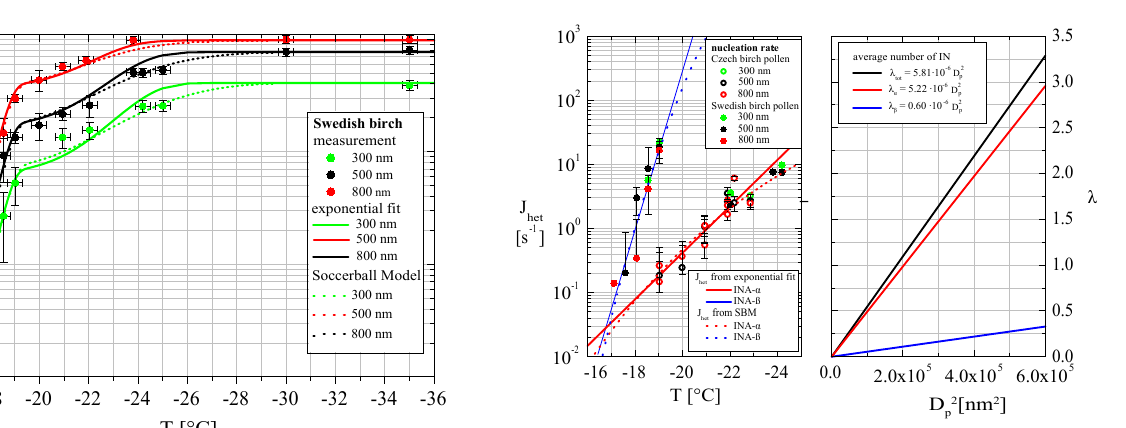
Fig. 10. Ice fraction f ice as a function of temperature T for 300, 500 and 800nm Swedish birch pollen washing water particles (dots) and model calculations for the different sizes (lines). The model calculation results from the combination of the INA- α and the INA- β . Therefore the parameterizations found for the INA- α (see Fig. 4) were used. The parameterization for the INA- β are A = 9 . 186 × 10 − 23 and B = − 2 . 822 ◦ C − 1 for the exponential fit of J het ,β (straight lines), and µ = 47 . 8 ◦ and σ = 0 . 03 ◦ for the SBM (dotted line).